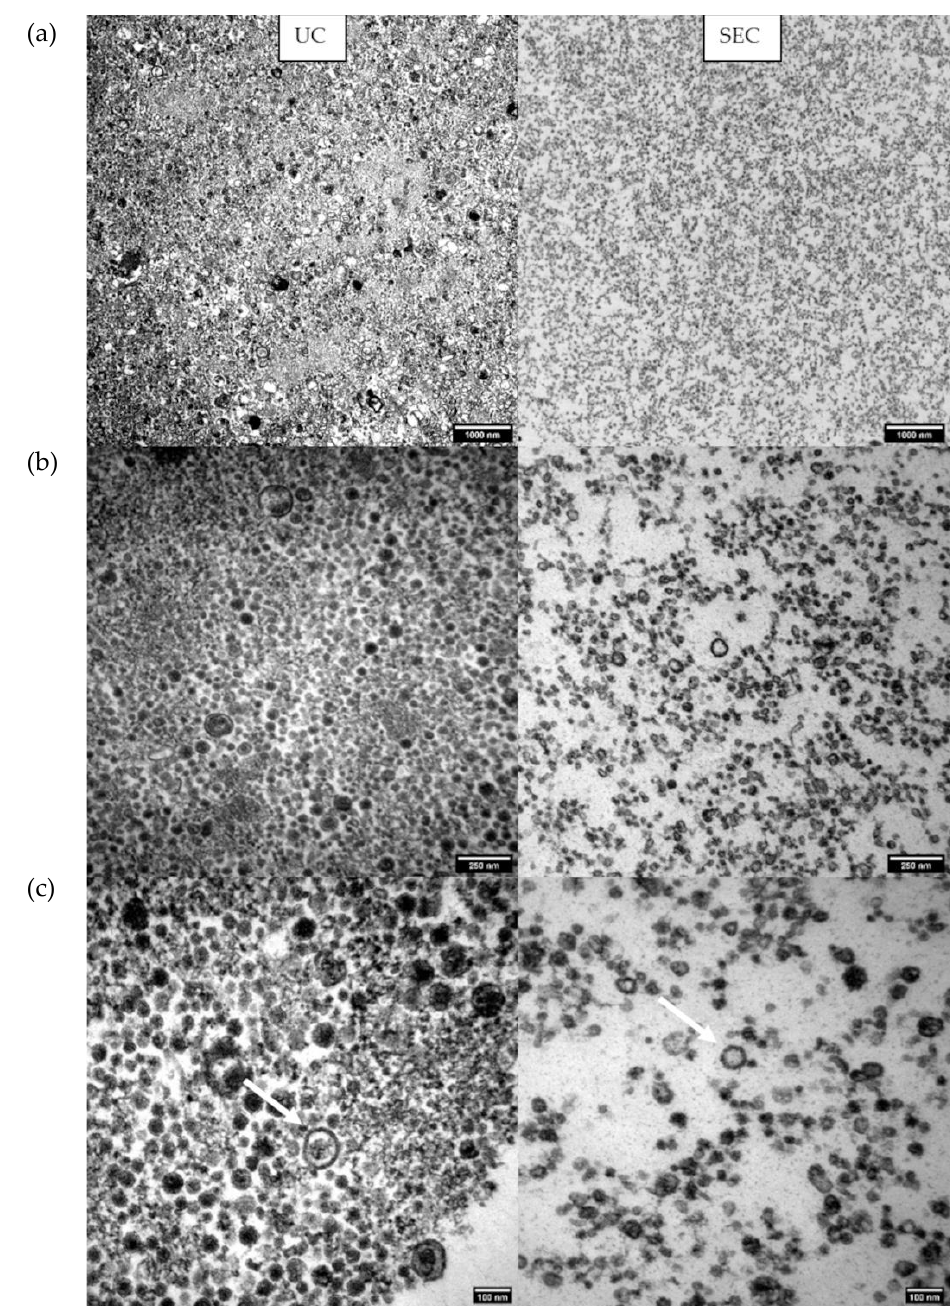
Figure 6. Transelectron Microscopy (TEM) images of the UC EV isolates in the left panels and the SEC EV isolates in the right panels taken at decreasing (top to bottom) magnifications: ( a ) 12,000× magnification gives an overview of the different sizes of the particles with a 1000 nm scale bar; ( b ) 50,000× magnification shows the different electron densities by different grey scales; ( c ) 85,000× magnification shows clearly the EVs identifiable by their lipid bilayer (arrows). In the UC isolates, the size distribution of the EVs is heterogeneous, ranging from large particle agglomerates to small EVs. In contrast, in the SEC isolates, particles are more uniformly sized without agglomerates.